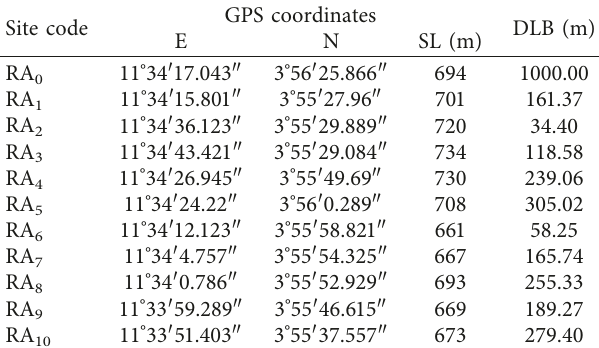
Table 1: Specifications of the monitoring